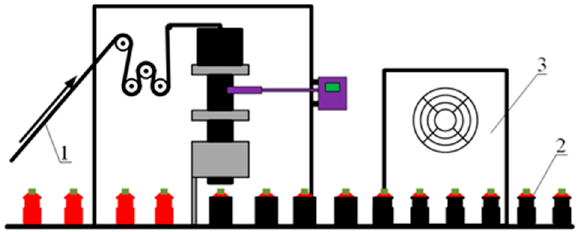
Figure 3. Schematics of heat shrinkage of films with hidden marking on containers using industrial equipment. 1—film with hidden marking, 2—container, 3 ‐ thermostat.